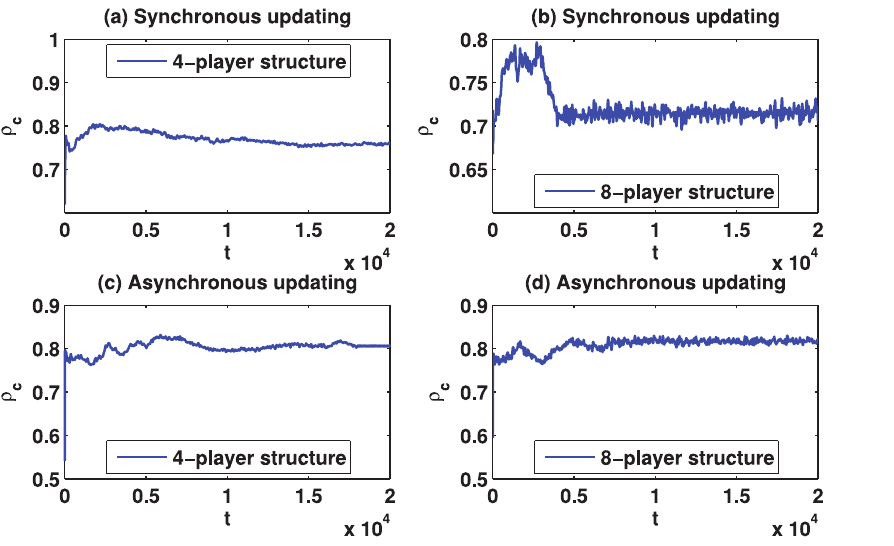
Figure 12. (Color online) Cooperation level r c as a function of the evolution time on different square lattices under the Fermi rule given that R ~ 10 . (a) Results on the square lattice with 4-player neighborhood and synchronous updating; (b) Results on the square lattice with 8- player neighborhood and synchronous updating; (c) Results on the square lattice with 4-player neighborhood and asynchronous updating; (d) Results on the square lattice with 8-player neighborhood and asynchronous updating.